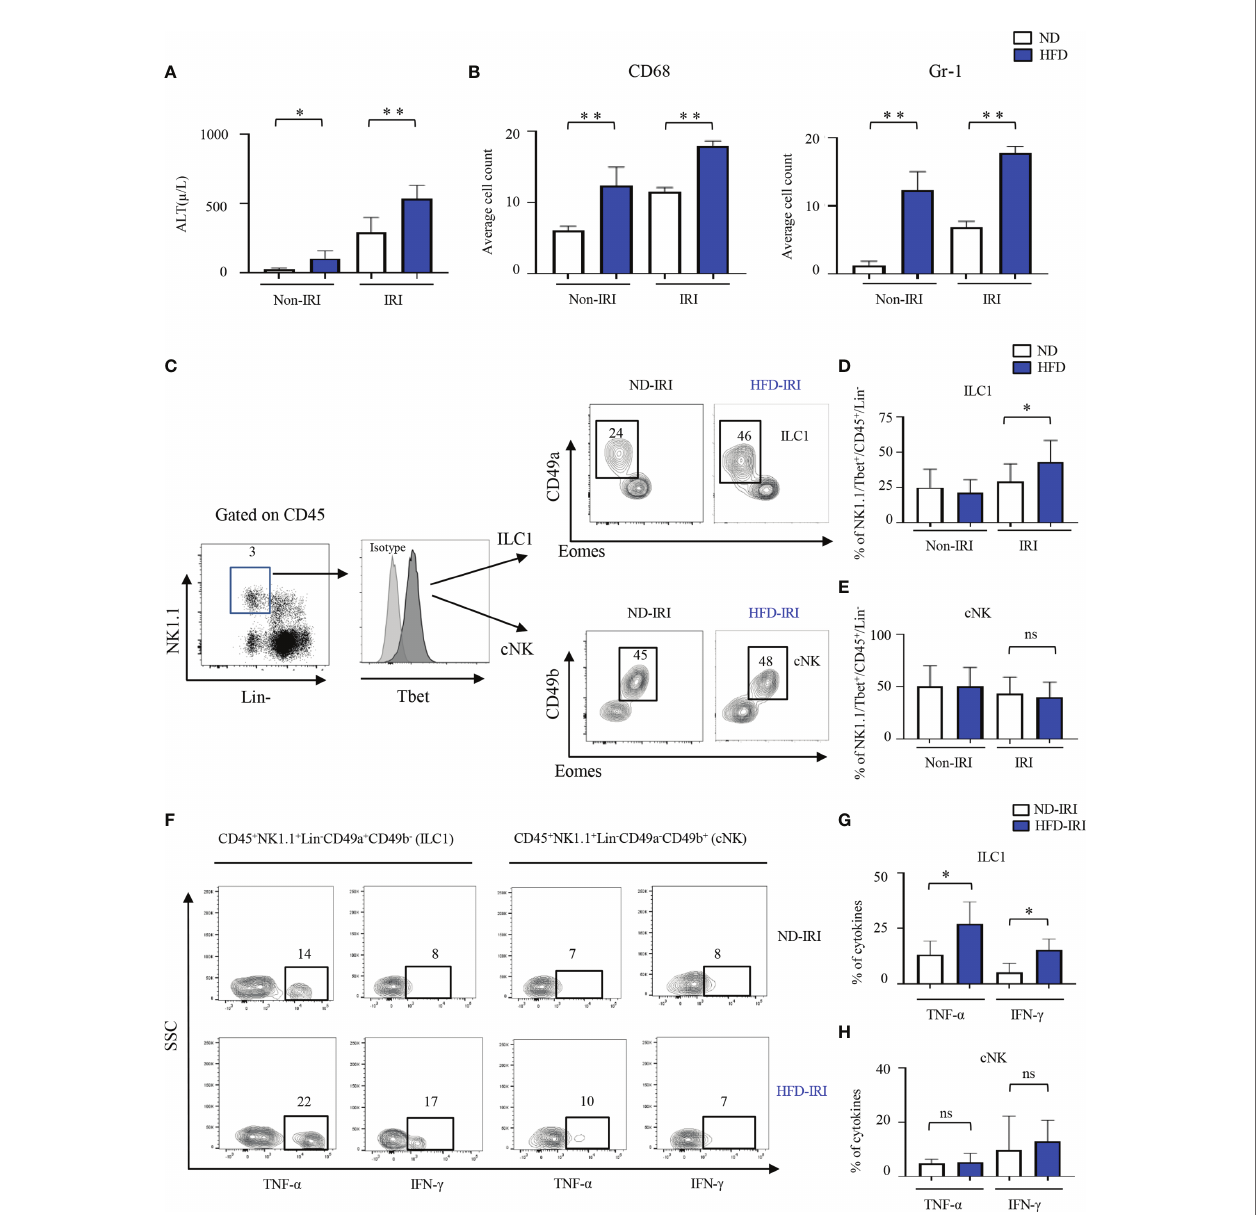
FIGURE 1 | ILC1s are elevated in the liver of C57B/6 wild-type HFD-IRI mice and produce IFN- g and TNF- a . C57B/6 wild-type mice were fed either standard chow (normal diet, ND) or a lard-based high fat diet (HFD). HFD was started at fi ve-to-seven weeks of age and maintained for 12 weeks. All mice were 17-23 weeks of age at the time of experimentation. A 45-minute partial warm ischemia time was used for IRI experiments. All analysis was performed following 24 hours of reperfusion. (A) Serum alanine aminotransferase (ALT), the indicator of liver damage, was measured (n=3-7 mice). (B) Numbers of the in fi ltration of in fl ammatory cells (i.e., CD68 + and Gr1 + ) in the ND and HFD mice after IRI were quanti fi ed (n=9-10). (C) Gating strategy of ILC1s and cNKs from the hepatic lymphocytes: lineage- negative (Lin - ) NK1.1 + cells expressing CD45 were identi fi ed as ILC1s and cNKs by expression of CD49a, CD49b, T-bet, and Eomes. Representative fl ow plots showing ILC1 and cNK subsets in ND-IRI and HFD-IRI. The percentages of ILC1s (D) and NKs (E) in ND and HFD mice after non-IRI or IRI (n=7-16 mice). (F) Representative fl ow plots showing intracellular cytokine production (IFN- g + and TNF- a + cells) in ND-IRI and HFD-IRI. Fresh hepatic lymphocytes were stimulated with PMA/ionomycin for 4 hours in the presence of IL-12, IL-15, and IL-18. FACS plots gated on live, CD45 + , Lin - , NK1.1 + , CD49a + and CD49b - for ILC1s and CD45 + , Lin - , NK1.1 + , CD45a + and CD45b + for cNKs. The percentage of cytokines from ILC1 gated (G) and NK gated (H) cells in ND-IRI and HFD-IRI mice (n=5 mice per group). Signi fi cance was determined using Mann Whitney Test. *p<0.05; **p<0.01; ns, not signi fi